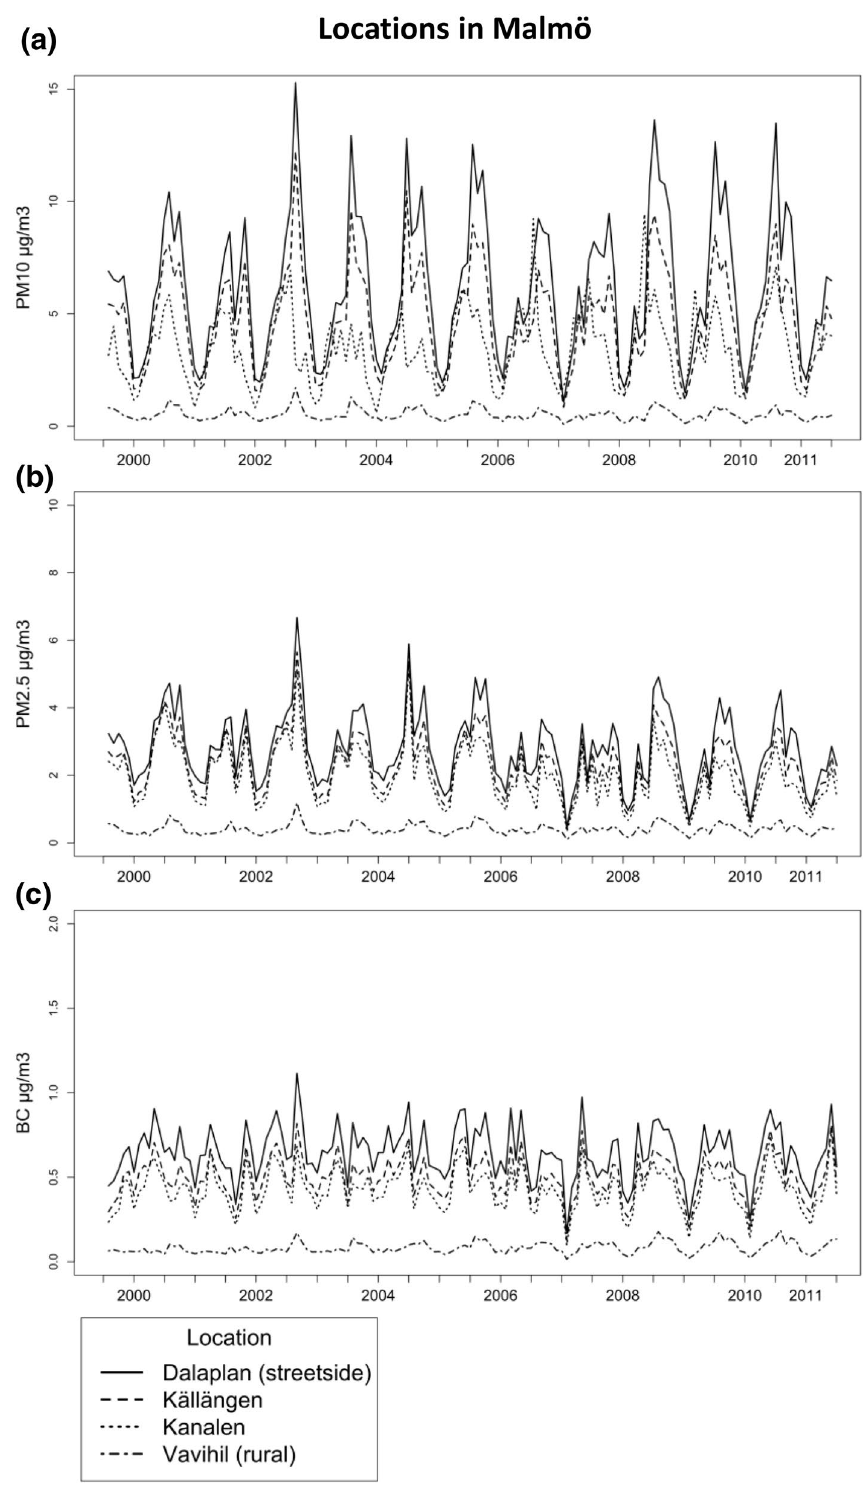
, b PM and 10 2.5